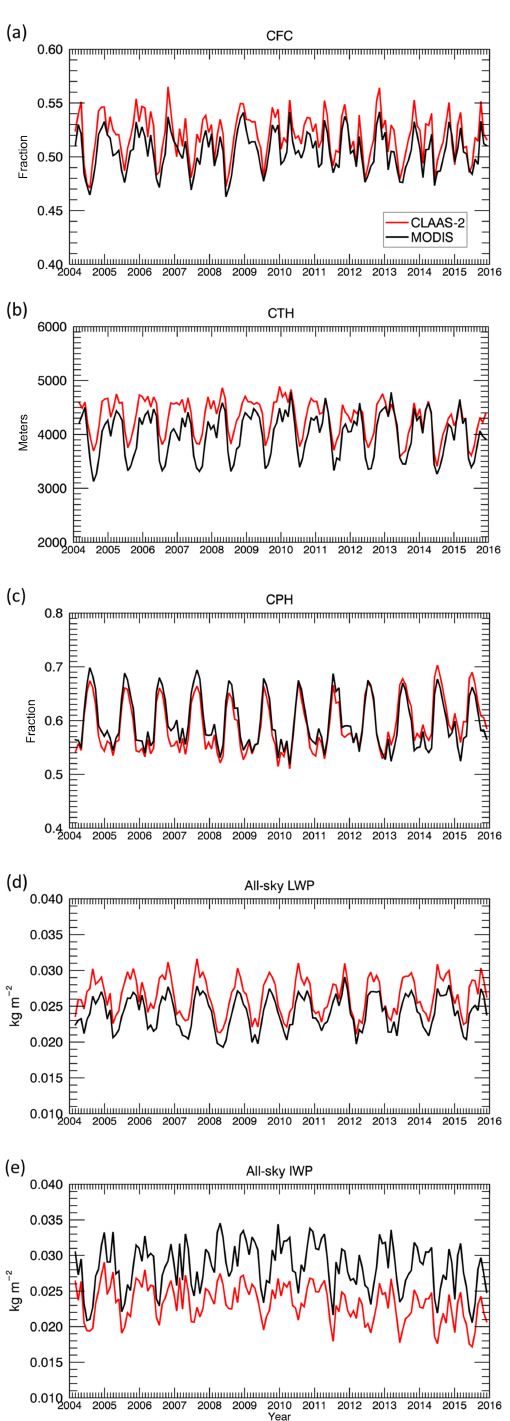
Figure 11. Time series of the 45 ◦ W–E and S–N area-averaged CFC (a) , CTH (b) , CPH (liquid cloud fraction) (c) , all-sky LWP (d) and all-sky IWP (e) from CLAAS-2 and MODIS. Aqua MODIS data were used in (a) and (c) ; average Aqua and Terra MODIS data were used in (b) , (d) and (e)